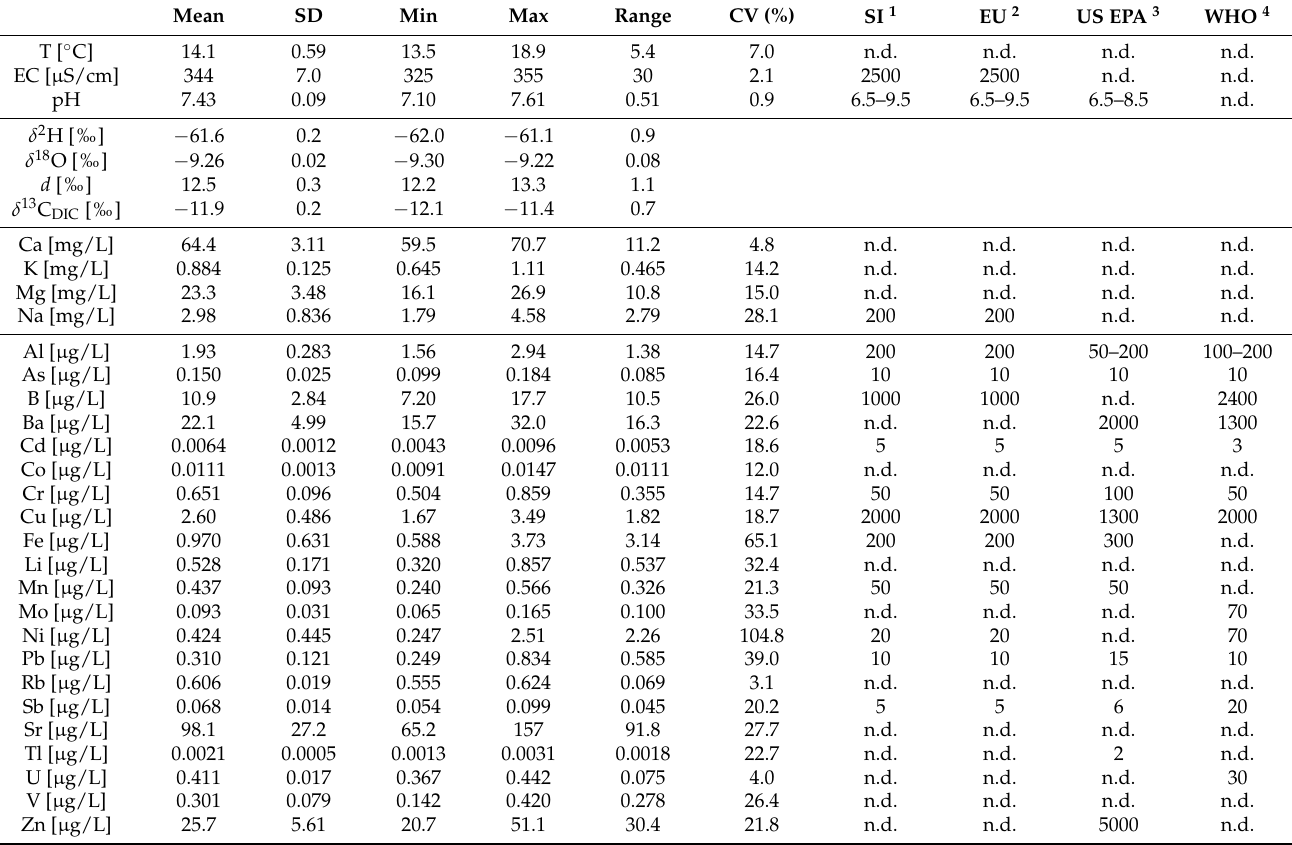
Table 1. Summary of basic statistics and SI, EU, US EPA, and WHO guidelines for tap